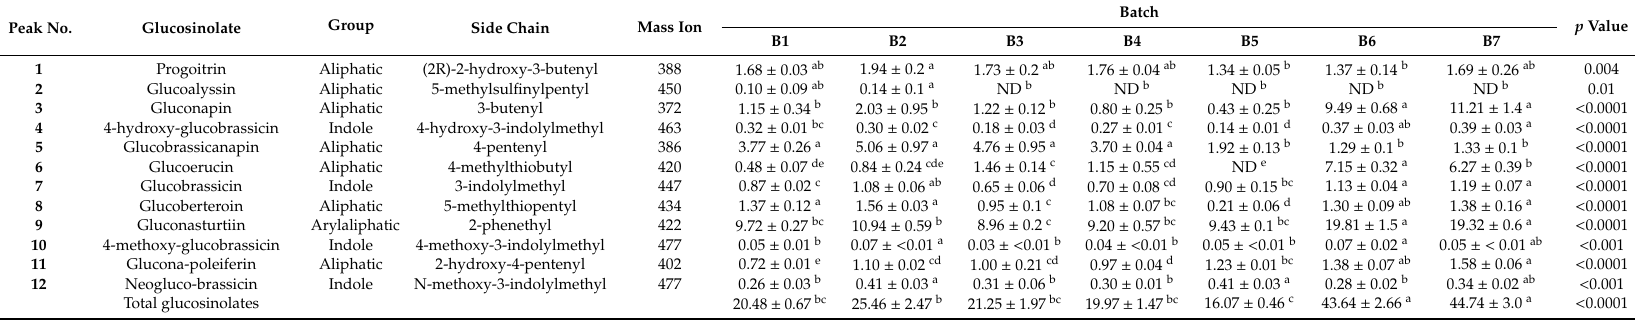
Table 3. Mean concentration of glucosinolates in seven batches of steamed-pureed turnip (B1 to B7). Results are expressed as µ molg-1 DW ± standard deviation. Di ff erent superscript letters indicate significant di ff erences in mean concentration between batches. Abbreviation: ND, not detected. Peak